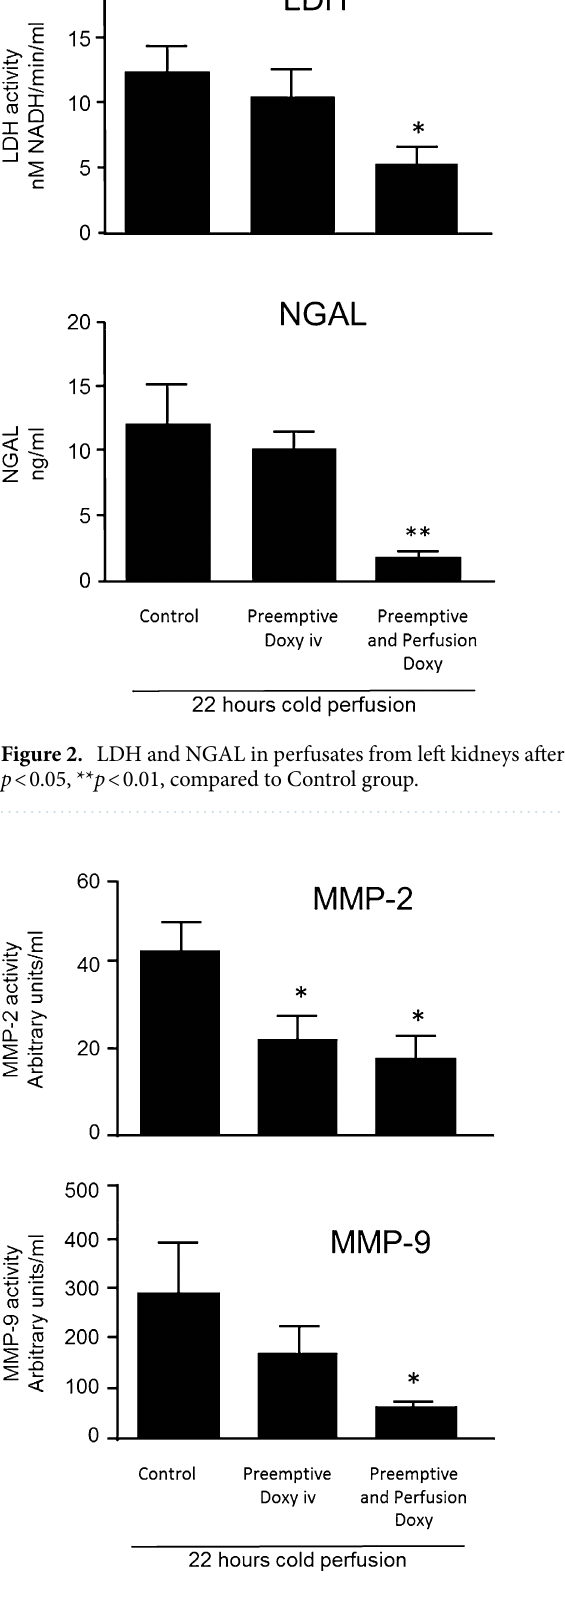
Figure 3. MMP-2 and MMP-9 in perfusates from left kidneys after 22 h of machine cold perfusion at 4 °C. * p < 0.05 compared to control